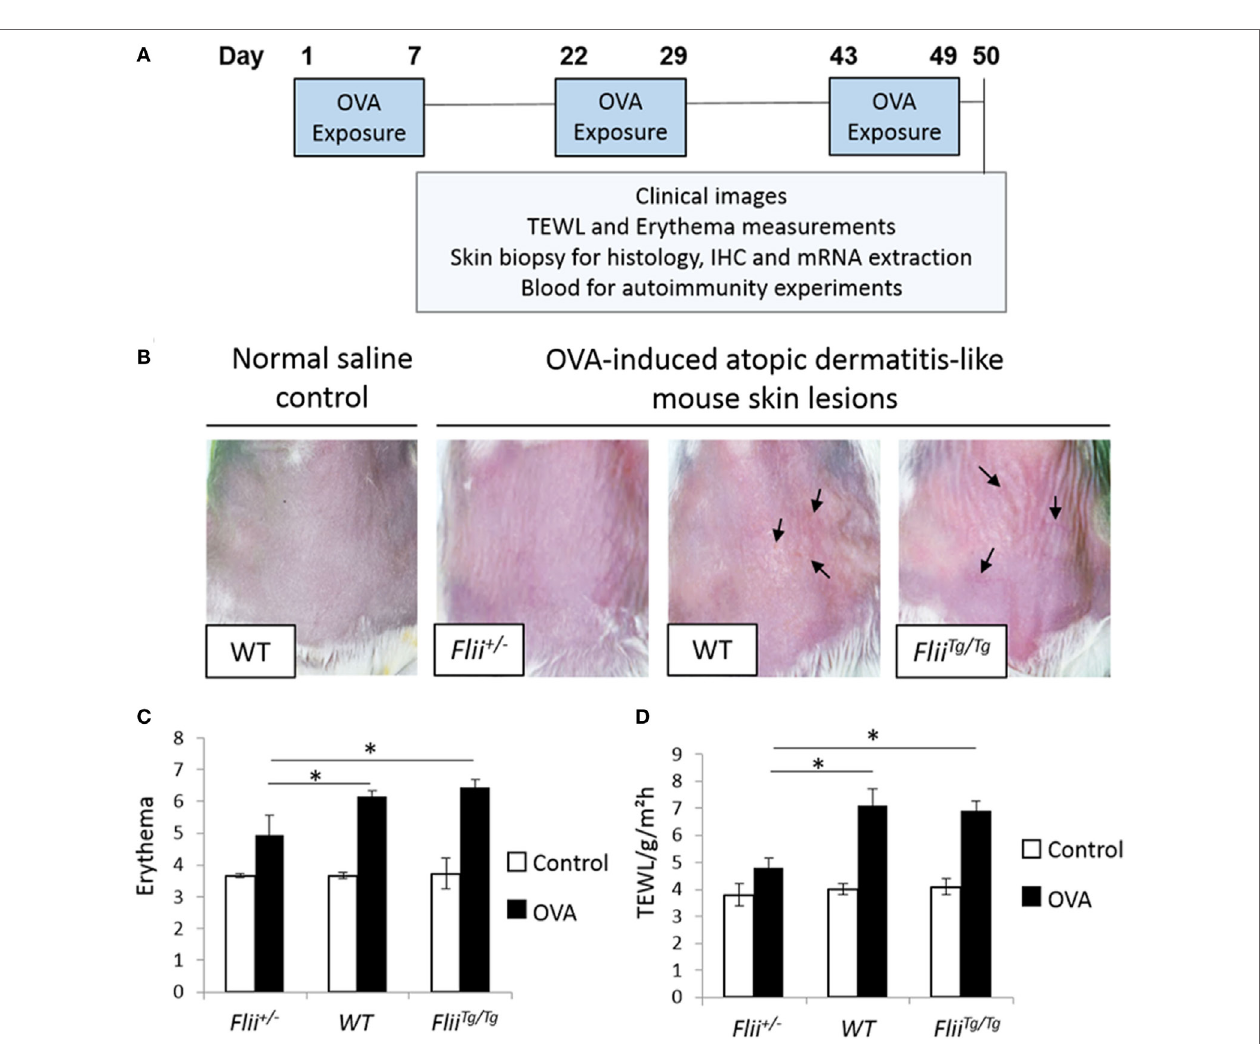
FigUre 1 | Reduced Flii expression leads to decreased development of OVA-induced atopic dermatitis (AD)-like lesions. (a) Ovalbumin (OVA) exposure protocol, including a total of three 1-week exposures to 100 µl 0.1% OVA or saline control on patches separated from each other by 2-week resting interval. (B) Representative clinical images of OVA-induced AD-like skin lesions in mice differential Flii expression illustrating high degree of erythema, skin thickening, and scaling (black arrowhead) in WT and Flii Tg/Tg mice exposed to OVA. (c,D) OVA exposure leads to development of AD-like lesions demonstrated by increased erythema and transepidermal water loss (TEWL). Decreasing Flii expression reduces development of AD-like lesions with significantly decreased erythema and TEWL measurements compared to OVA exposed skin of WT and Flii Tg/Tg animals. n = 8. Mean ± SEM. * <